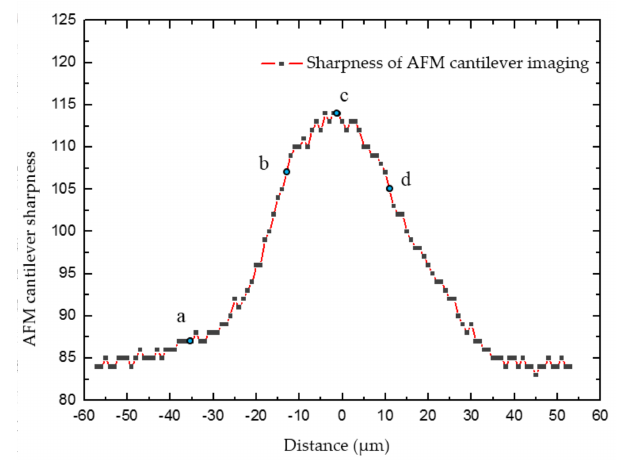
Figure 5. When the AFM cantilevers were moved from underneath to above of the focal plane along the Z-direction at a speed of 2 µ m/s, the sharpness of the AFM cantilever image was changed; this was described by the mean gray value of pixels within the AFM cantilever contour.